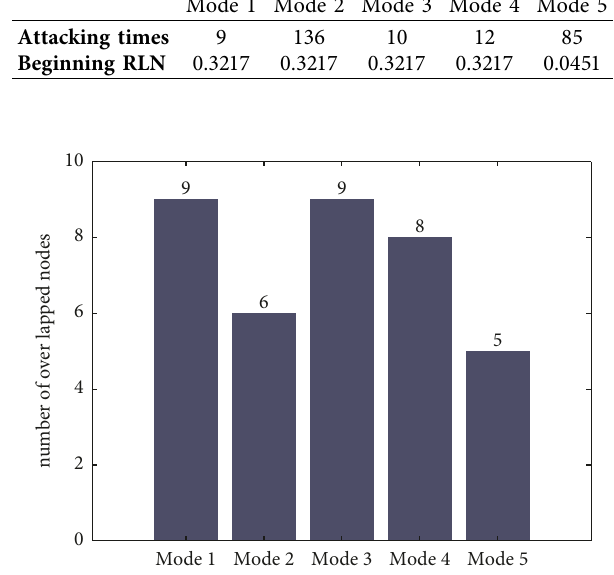
Figure 12: Number of overlapped